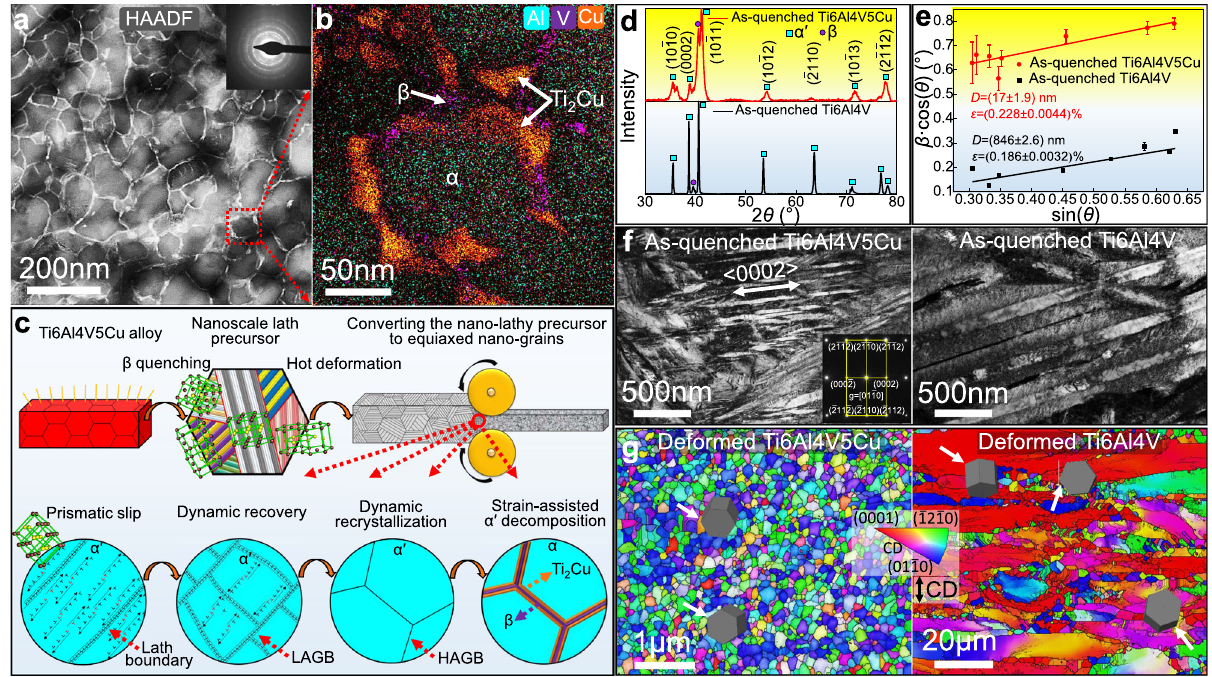
Fig. 2 Microstructure and formation mechanisms. a Transmission electron microscopy (TEM) performing under the high-angle annular dark fi eld (HAADF) mode of the as-prepared Ti6Al4V5Cu alloy. b X-ray energy dispersive spectroscopy (XEDS) analysis. c Schematic showing the eutectoid element alloying, quenching and hot deformation (EQD) fabricating strategy. d X-ray diffraction analysis (XRD) of as-quenched materials. e β ·cos( θ ) versus sin( θ ) curves. Lattice strain ε and crystalline domain size D were determined by slopes and intercepts of curves. Error bars indicate standard deviations of measured β ·cos( θ ) value. f TEM bright fi eld images of as-quenched materials. g Inverse pole fi gures (IPF) of deformed materials, compressive direction (CD) is denoted in the fi